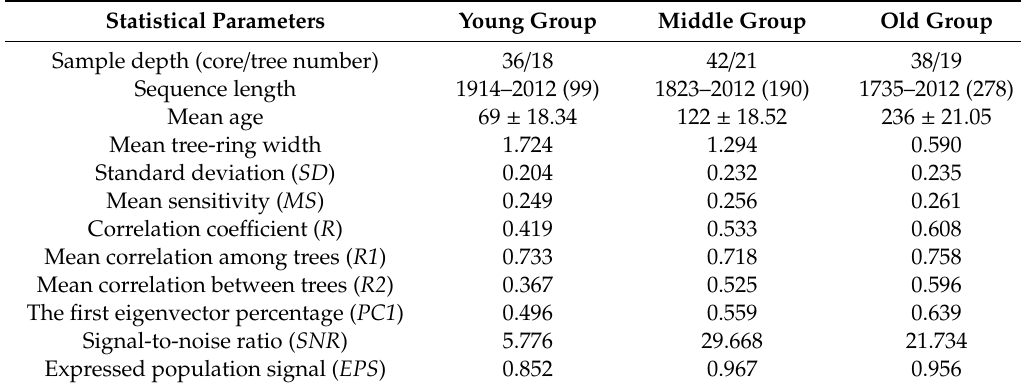
Table 1. Statistical characteristics of the tree-ring width chronologies of the three age groups of Schrenk spruce (period of dendroclimatic analysis: